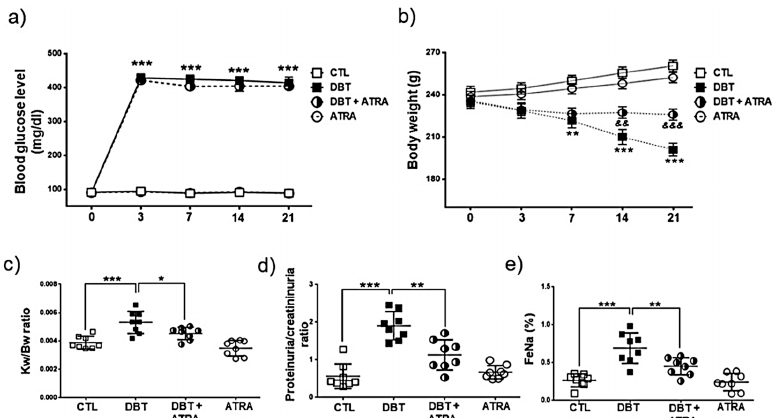
Figure 1. All-trans retinoic acid (ATRA) treatment ameliorated body weight loss, proteinuria, renal hypertrophy and fractional excretion of sodium induced by diabetes. ( a ) Blood glucose levels and ( b ) body weight were monitored at 0, 3, 7, 14, and 21 days after streptozotocin (STZ)-injection. At three days, rats were treated with ATRA (1 mg/kg) until day 21. ATRA did not affect hyperglycemia in diabetic groups. However, ATRA treatment prevented loss of body weight induced by diabetes. ( c ) Kidney weight/body weight (KW/BW) ratio, ( d ) proteinuria/creatininuria ratio, and ( e ) increased fractional excretion of sodium (FeNa). ATRA significantly reduced STZ-induced increase in the above parameters on day 21. Data are mean ± SD from eight rats per group. * p < 0.05, ** p < 0.01 *** p < 0.001 vs CTL group; && p < 0.01, &&& p < 0.001 vs DBT group.